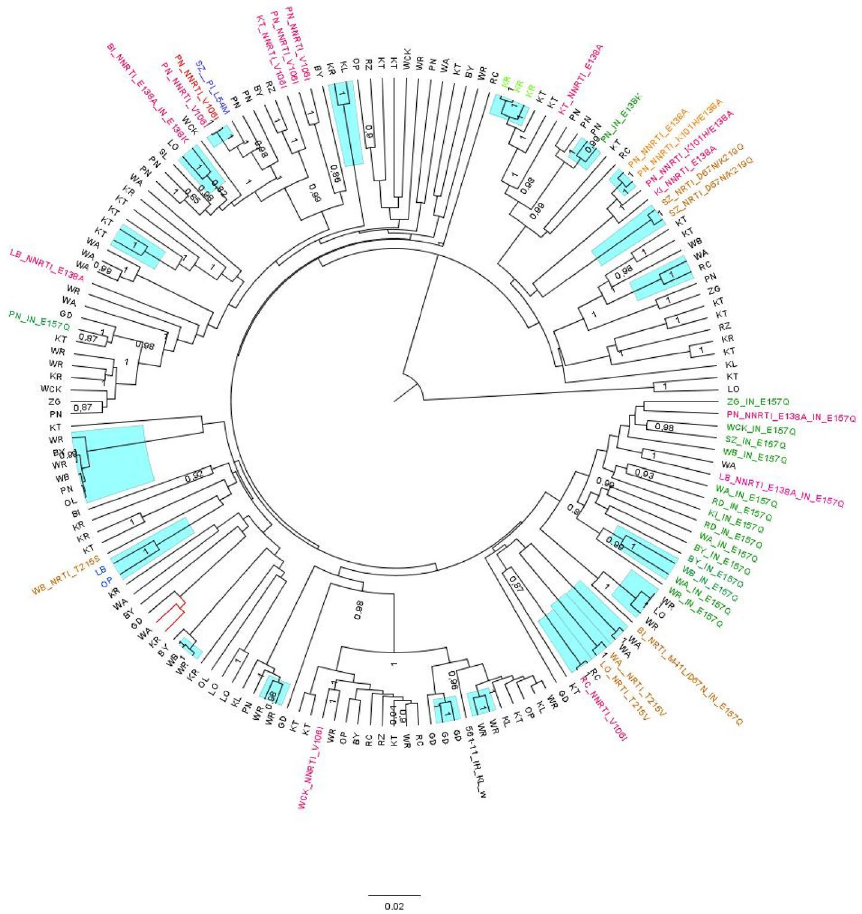
Figure 4. MCMC tree showing the relationship between clusters and mutations and city of diagnosis for subtype B with the inclusion of the protease/reverse transcriptase region of the of the subtype B/A6 recombinant (tree branches marked in red). Transmitted drug resistance substitutions were color-coded and included at the external taxonomical units: brown—resistance against nucleoside reverse transcriptase inhibitors, red— resistance against non-nucleoside reverse transcriptase inhibitors, blue – resistance against protease inhibitors, green—resistance against integrase inhibitors . Clusters have been indicated on the tree with magenta highlight using < 1.5% genetic distance and > 90% branch